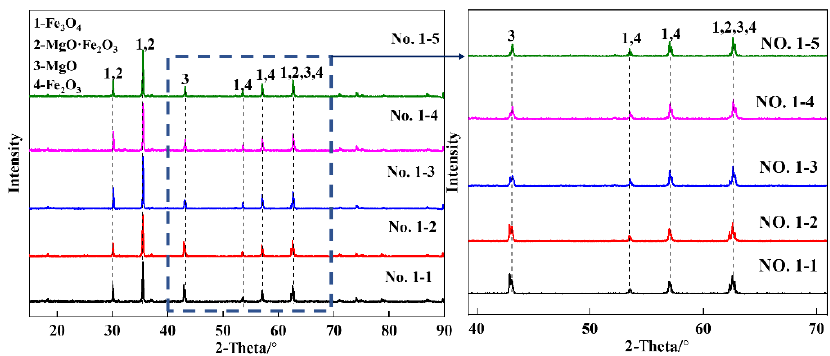
Figure 10. The XRD analysis of Fe 2 O 3 -MgO of samples after reduction.